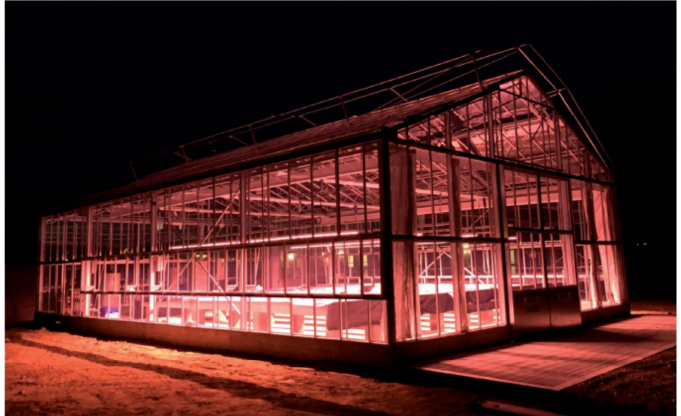
Figure 1. Innovative greenhouse realized at Cersaa (Center for Agricultural Experimentation and Assistance) in Albenga, Liguria Region, Italy. The light in the greenhouse is the result of a low- consumption lighting system based on LED